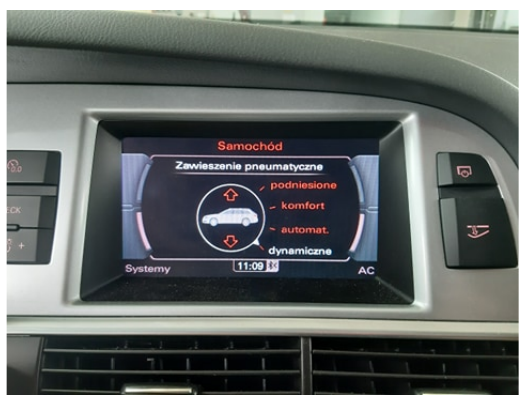
Figure 3: View of the air suspension height control panel in an Audi A6 passenger